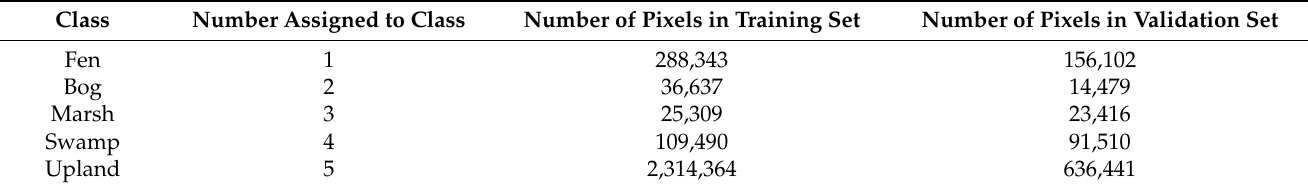
Table 1. Land-cover class assignment and the number of pixels contained in the training and validation